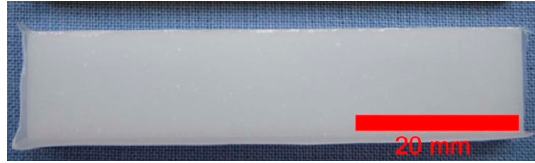
Figure 2. GUR molds after pressing, red bar = 20 mm.